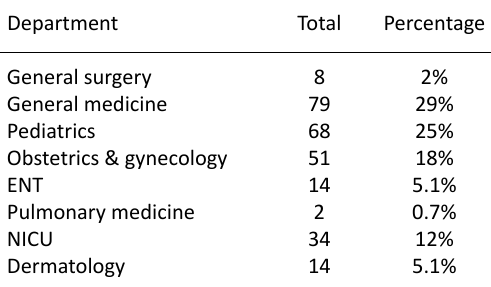
Table 1. Samples distribution among all the departments